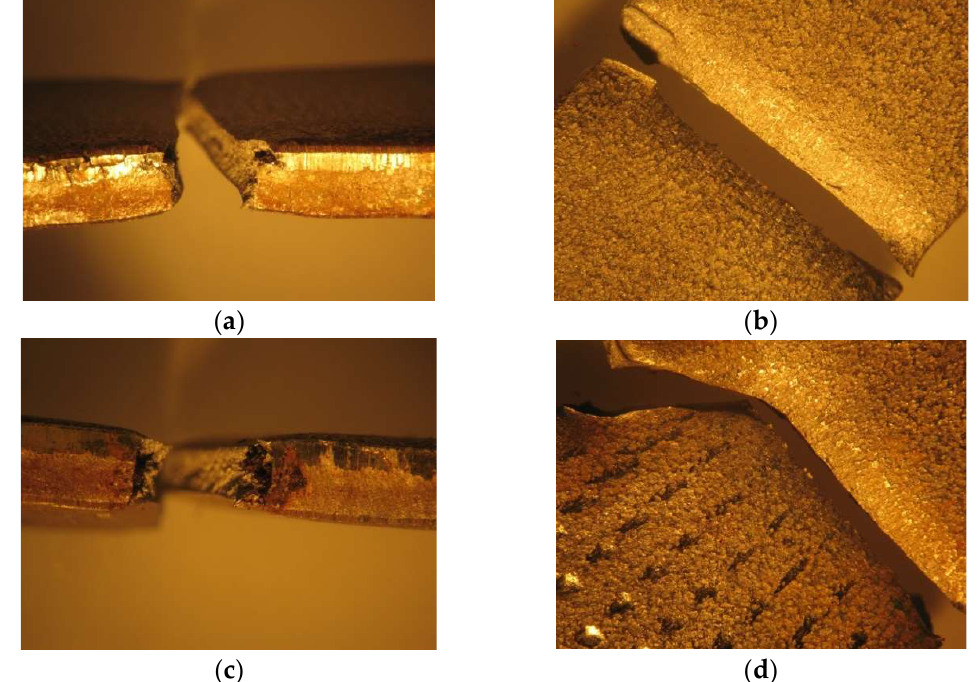
Figure 13. Fracture cross-section of the AISI 321 samples immersed in 5% NaClO and 100% NaClO for three weeks ( a , c ) and three months ( b , d ).